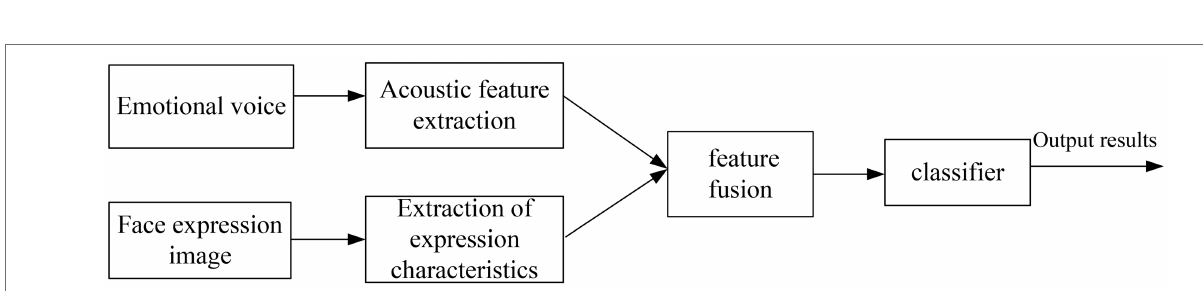
TABLE 1 | Features extracted from multi-modal emotion recognition experiments.